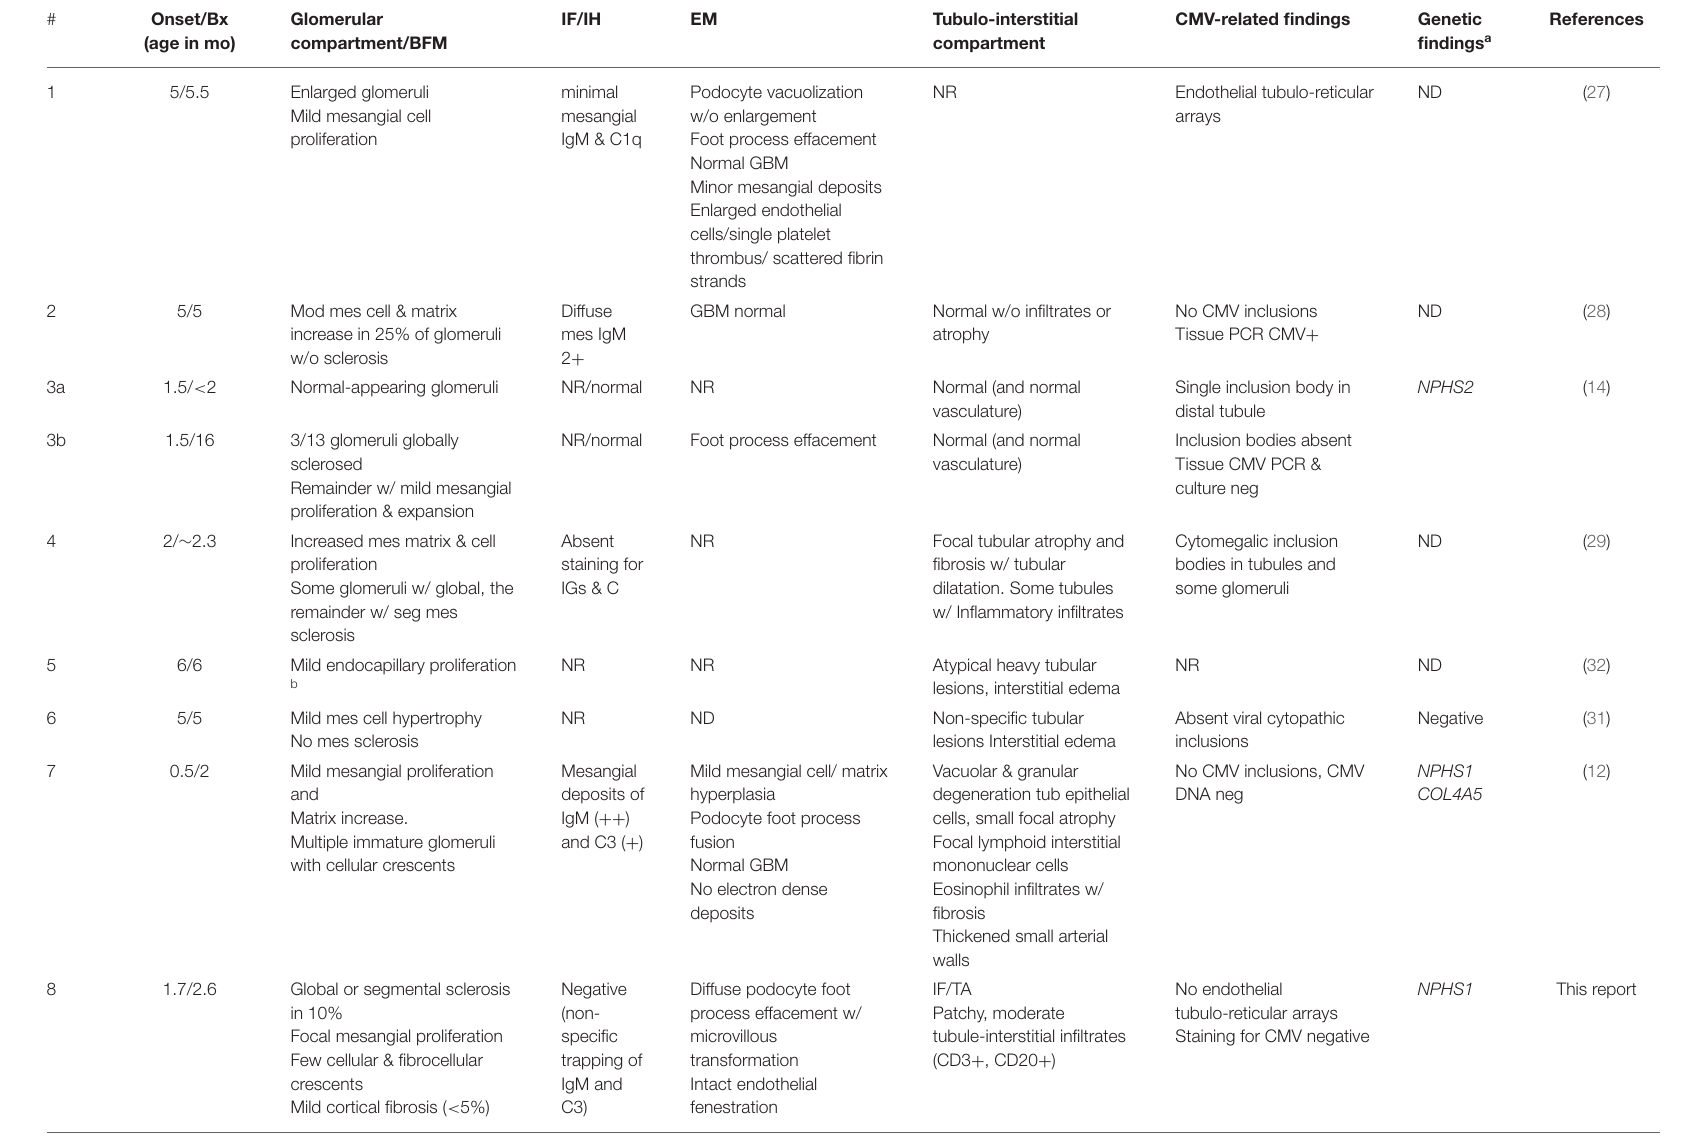
TABLE 3 | Renal biopsy findings (Literature review and